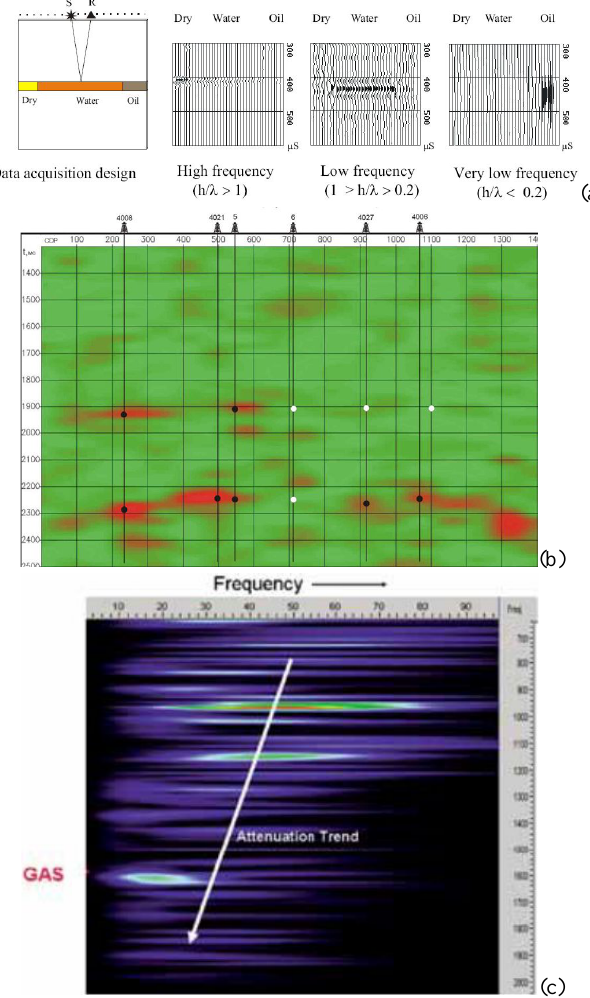
Fig. 3. (a) Laboratory seismic reflection experiment (left panel), and data filtering results, (b) low-frequency results that show the presence of oil in wells (black circles) in the West Siberian oil field (Goloshubin et al., 2002), and (c) time–frequency analysis using spectral decomposition for a seismic trace containing a gas reservoir. The white line illustrates the progress reduction of the peak frequency due to attenuation. The gas reservoir has anoma- lously low peak frequency (Castagna and Sun, 2006).